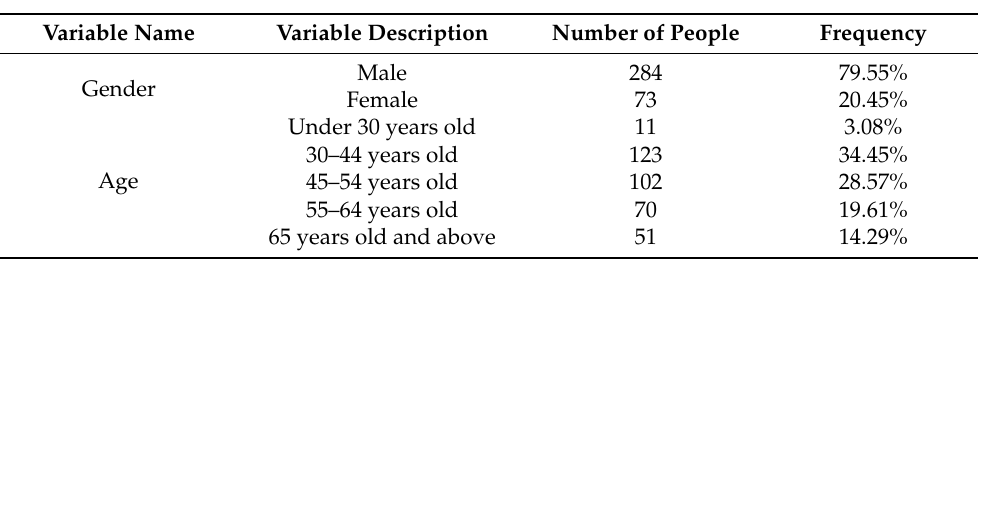
Table 2. Basic characteristics of interviewed